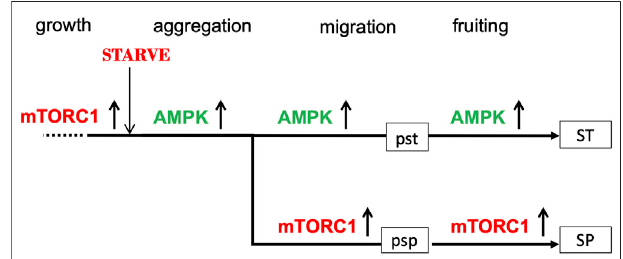
FIGURE 1 | Suggested roles of AMPK and mTORC1 activities in the prestalk(pst)and prespore(psp)pathways.Duringgrowth, mTORC1 isactive (upward arrow) and AMPK activity is low (not shown). Upon nutrient withdrawal, mTORC1 activity is rapidly switched off and AMPK activity upregulated (upward arrow); asaresult, aggregative stage gene expression is turned on, growth is arrested and autophagy activated. At the mound stage, mTORC1 is re-activated in some 80% of the amoebae (and AMPK downregulated) and expression of the prespore transcriptome is initiated; AMPK continues to be highly active in the remaining 20% of amoebae, which eventually form vacuolated stalk cells. The prestalk pathway isrepresented by a continuous straight line with the prespore pathway diverging from it to emphasise the asymmetry of the proposed bifurcation process. Only the member of the AMPK/mTORC1 pair that is highly active at any one time is